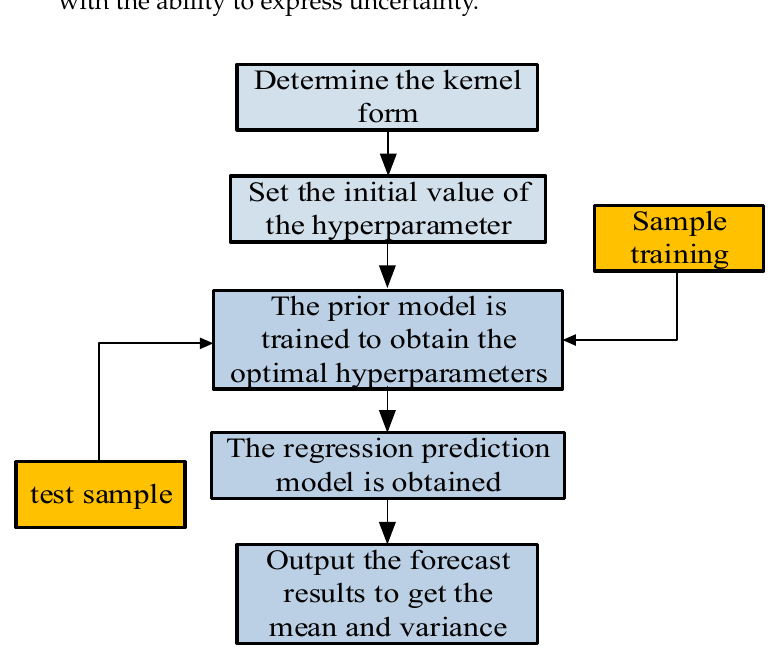
Figure 5. Gaussian process regression flow chart.